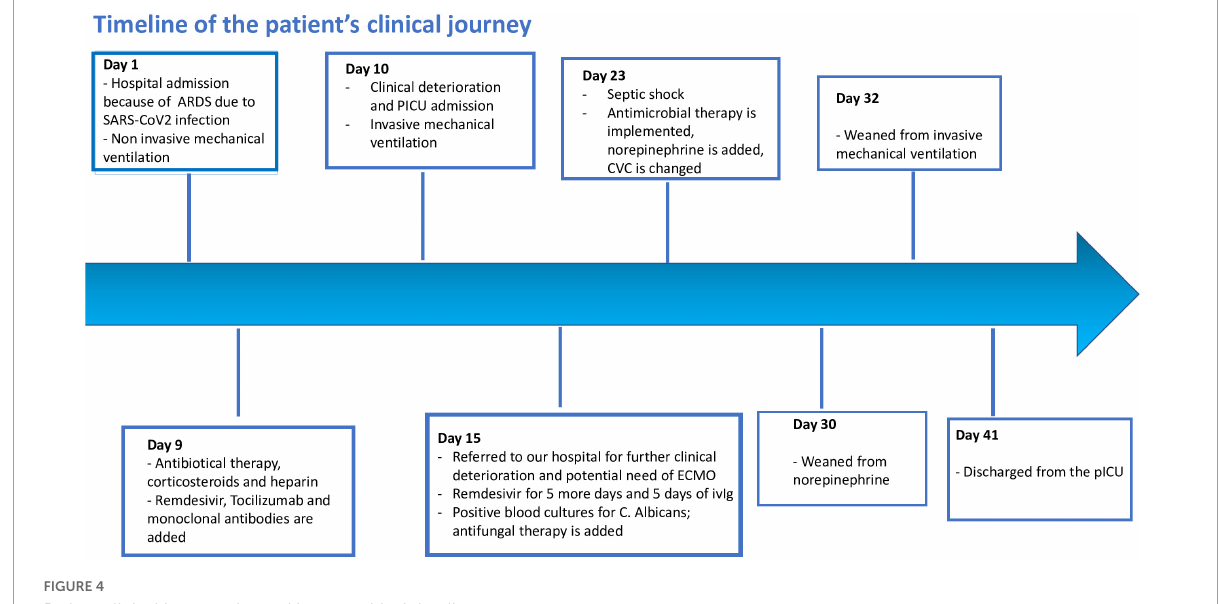
FIGURE4 Patient clinical journey showed by a graphical